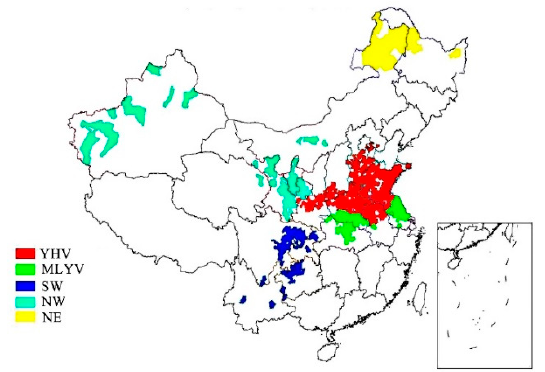
Figure 1. Sketch map of the five main wheat production areas in China (YHV, the Yellow and Huai Valley; MLYV, the Middle and Lower Yangtze Valley; SW, the southwest area; NW, the northwest area; NE, the northeast area) [20].